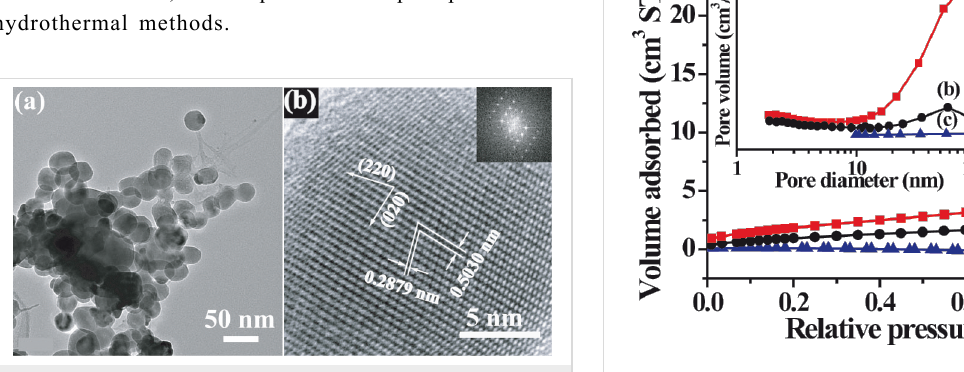
Figure 4: Nitrogen adsorption-desorption isotherms and corres- ponding pore size distribution curves (inset) of Ag 2 CrO 4